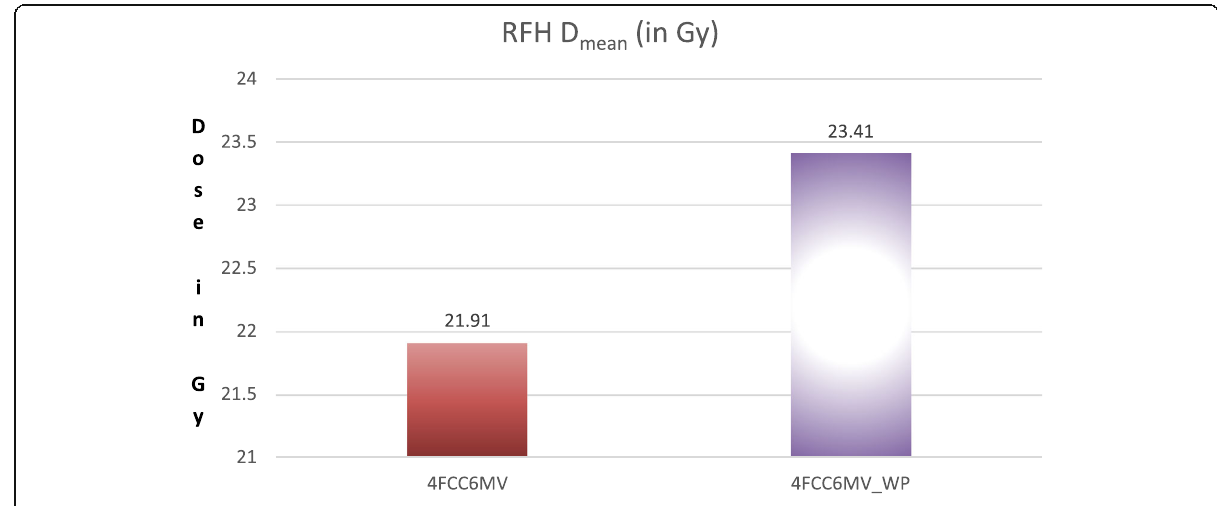
Fig. 6 Comparison of mean dose of the right femoral